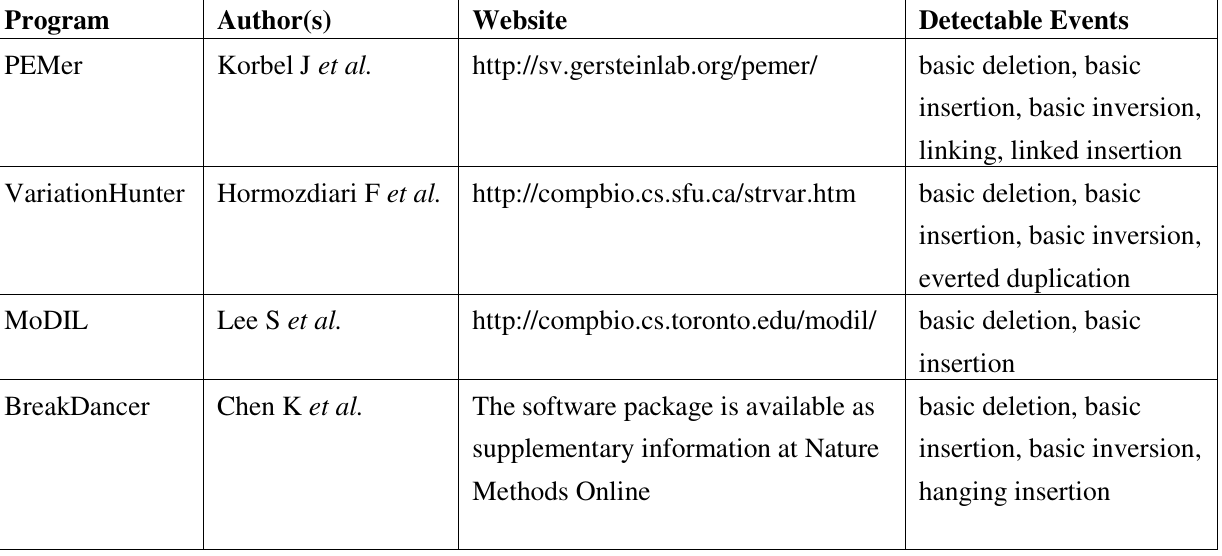
Table 4. A selection of PEM-based algorithms for the detection of Structural